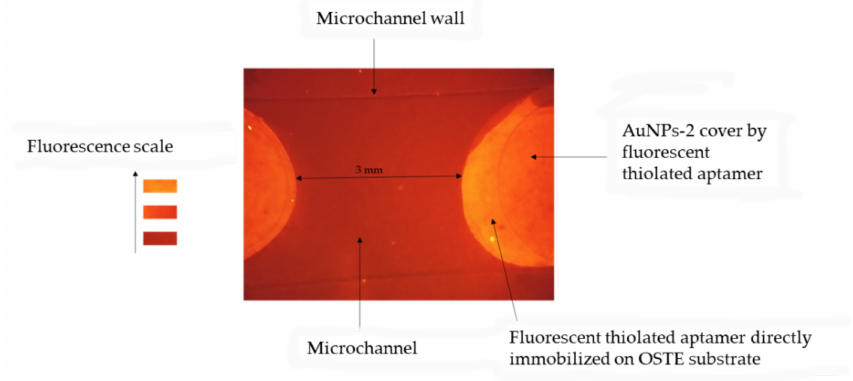
Figure 7. Fluorescence image of an open OSTE-microchannel coated with AuNPs-2 and functionalized with fluorescent aptamers. The image acquisition was recorded after rinsing the excess of the aptamer (See experimental part for more details on the experimental conditions and the fluorescence detection